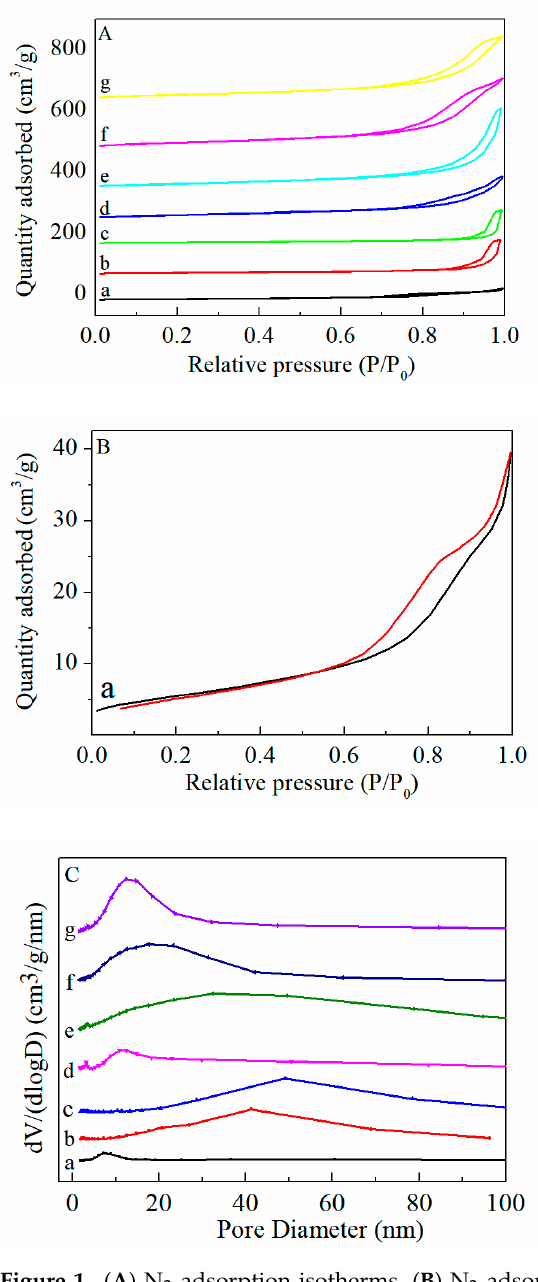
Figure 1. ( A ) N 2 adsorption isotherms, ( B ) N 2 adsorption isotherms of CeO 2 and ( C ) pore size distribution of ( a ) CeO 2 , ( b ) Fe 3 O 4 , ( c ) MnO 2 , ( d ) MnO 2 -CeO 2 , ( e ) FMC-1:5:5, ( f ) FMC-2:5:5 and ( g )